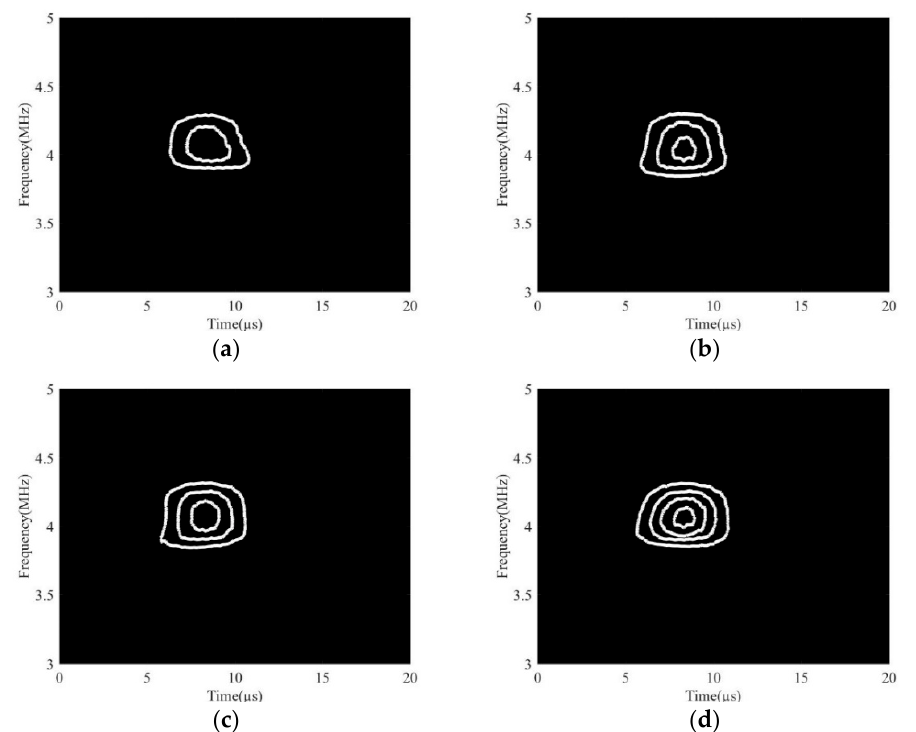
Figure 8. DWFP images corresponding to the second harmonic components for different porosities.